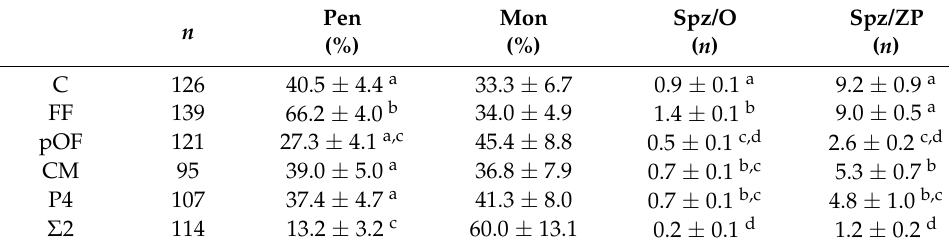
Table 3. In vitro fertilization (IVF) with spermatozoa selected by chemotaxis to reproductive biofluids in the chemotaxis system. The effective concentration of chemoattractants were added to well B of the chemotaxis system: Follicular fluid (FF), periovulatory oviductal fluid (pOF), secretions of the cumulus cells (CM) progesterone (P4), and a combination of chemoattractants ( Σ 2 = 1/3 of 0.25% FF + 1/3 of 0.25% pOF + 1/3 of 0.06% CM). Spermatozoa (20 × 10 6 cells/mL) were added to well A, and the system was incubated for 20 min. A group in which spermatozoa were selected without chemoattractant was used as the control (C). Spermatozoa recovered in well B were used to perform the IVF at 25 × 10 3 spermatozoa/mL. Eighteen hours after insemination, putative zygotes were fixed with glutaraldehyde and stained with the bisbenzimide solution. Evaluation was carried out by fluorescence microscopy. Four replicates were